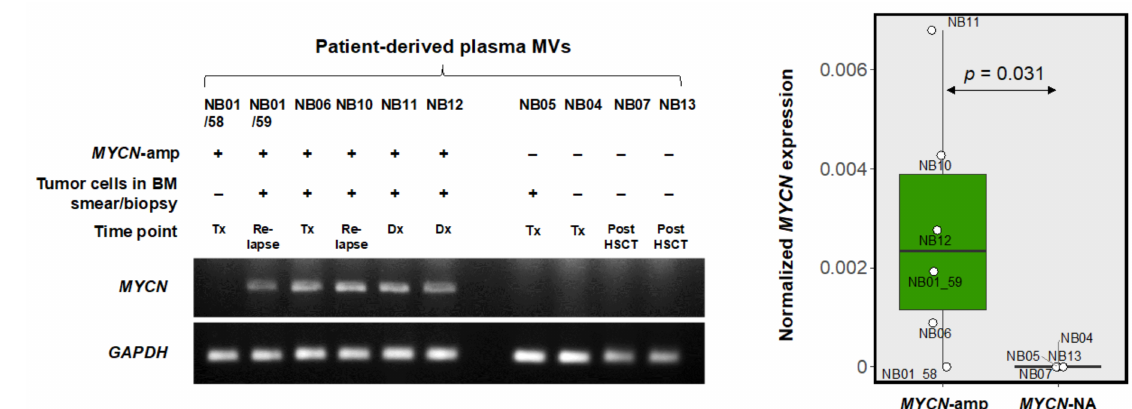
Figure 4. MYCN -MV detection in patient-derived bone marrow plasma specimens. MVs were isolated from 2 mL bone marrow plasma of NB patients and then were subjected to RNA extraction and qRT- PCR. The results are shown by the agarose gel electrophoresis (left panel) and the normalized MYCN mRNA expression to GAPDH (right panel). Abbreviations: BM, bone marrow; Dx, 1st diagnosis; HSCT, hematopoietic stem cell transplant; MYCN -amp, MYCN amplification; MYCN -MV, MYCN mRNA-containing microvesicle; MYCN -NA, MYCN non-amplification; Tx, ongoing